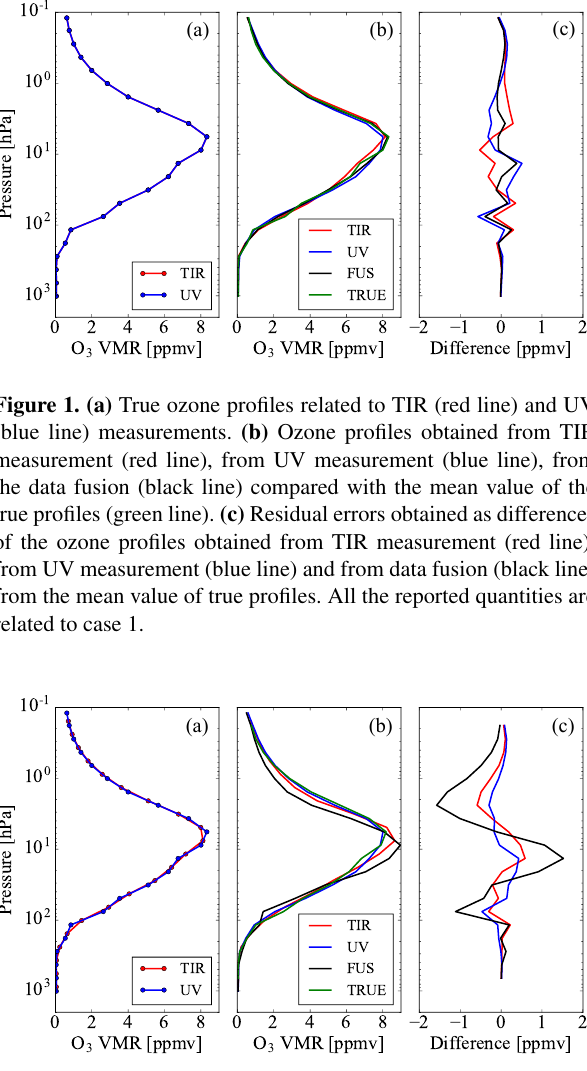
Figure 2. As Fig. 1 but for case 2.